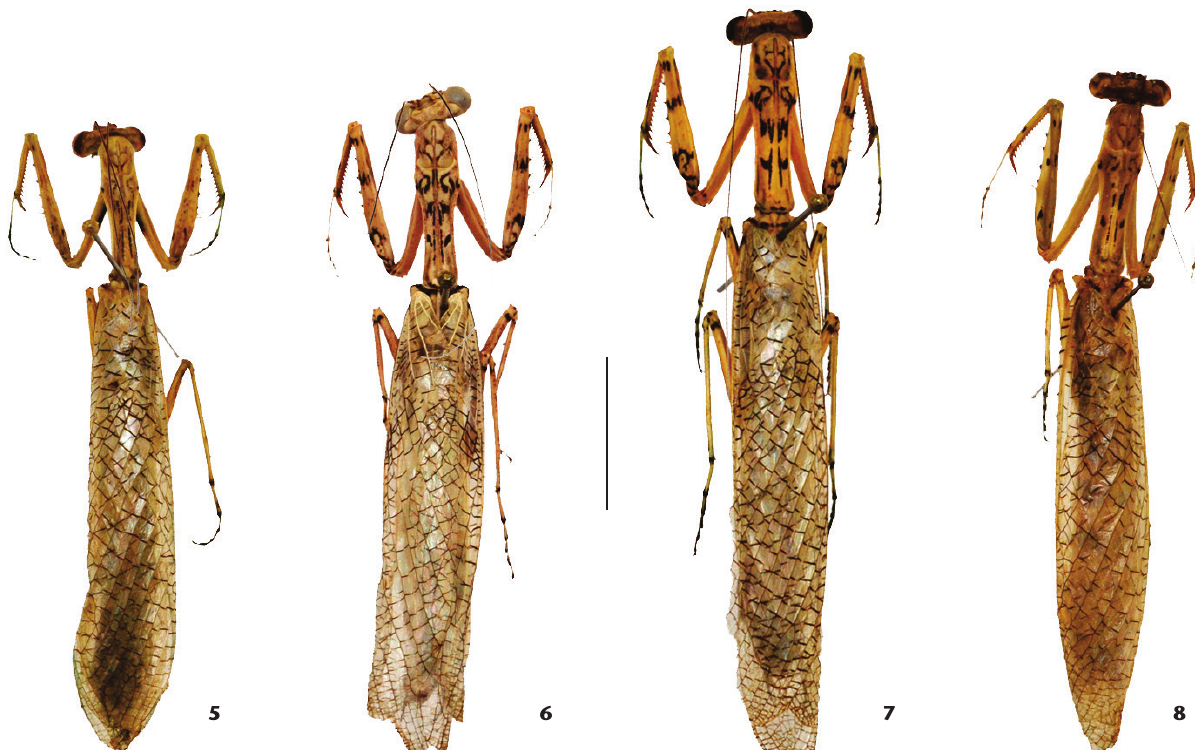
Figures 5-8. Males of Paraphotina (dorsal habitus): (5) P . caatingaensis from Bahia, Brazil; (6) P . insolita from Meta, Colombia; (7) P . occi- dentalis from Coari, Amazonas, Brazil; (8) P . reticulata from Maranhão, Brazil. Scale bar: 10 mm.